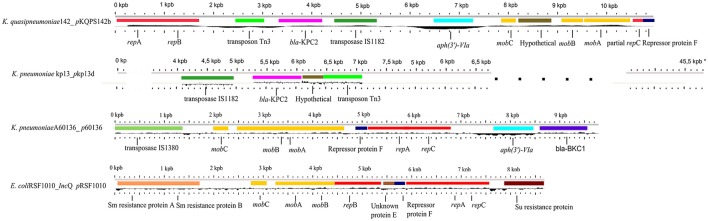
Comparison among the plasmids pKQPS142b of Kqps142, K. pneumoniae strain Kp13 (pKp13d), K. pneumoniae strain A60136 (p60136), and E. coli (IncQ pRSF1010). Homologous genes to plasmid pKPC142b carrying blaKPC−2 were obtained by BLASTn, and represented by the same color in other species, each color defined to a specific gene. Black line represents the GC content. Features of each plasmid were obtained using the GView program, with modifications.*The pKp13d is significantly larger than other compared elements. The genome length scales were adapted to emphasize only the region with similarity to pKQPS142b.